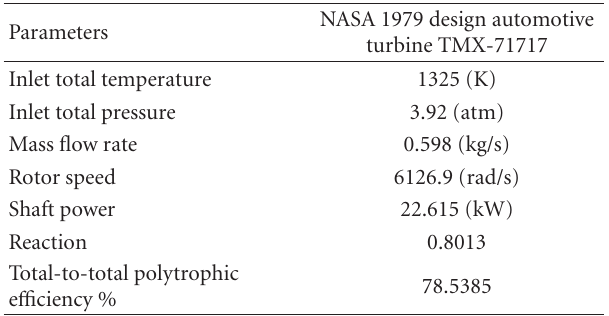
Table 2: Operating conditions for NASA-designed